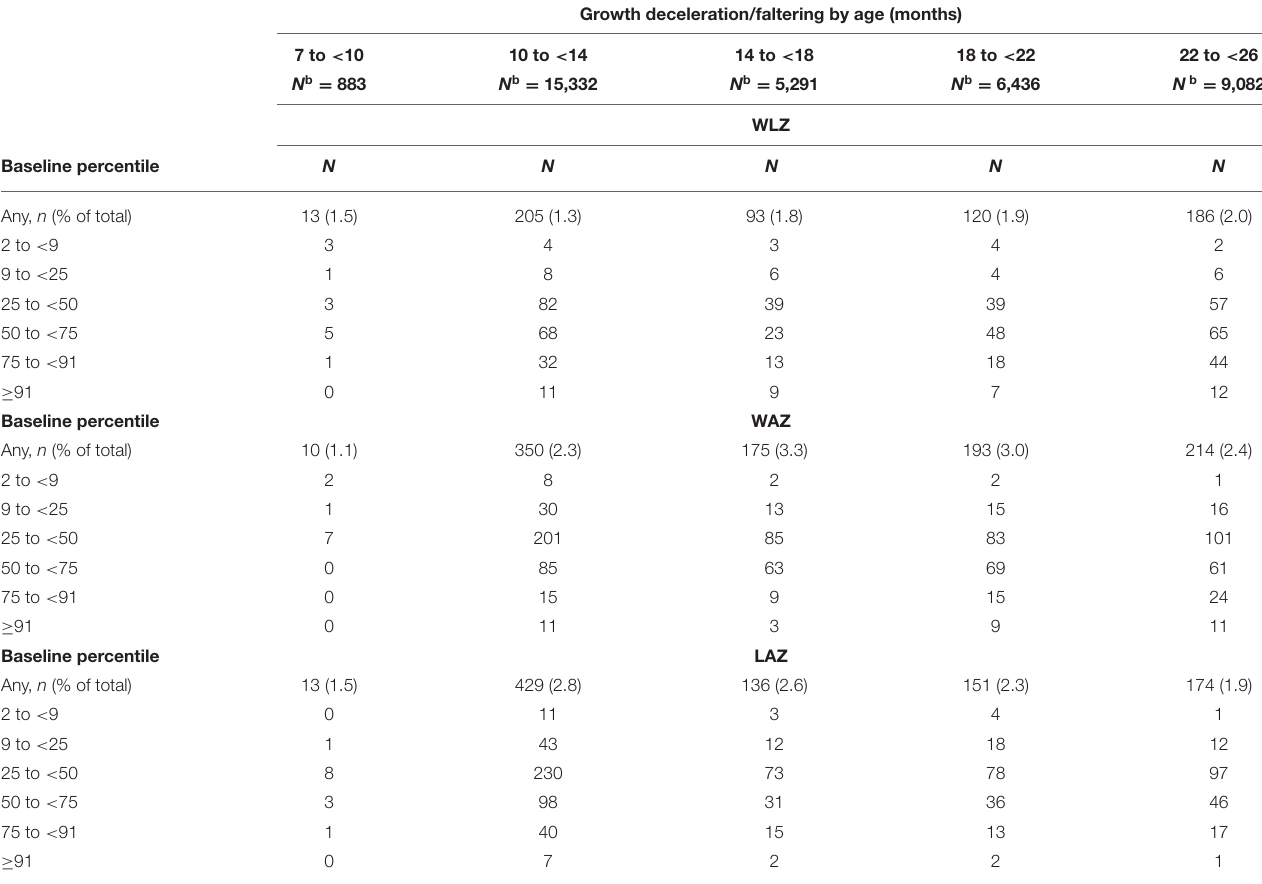
TABLE 2 | Frequency of growth deceleration/faltering a between 6 months and ages up to 26 months among WIC participating children in Southern California, by initial CDC anthropometric percentiles ( N = 16,255). Growth deceleration/faltering by age